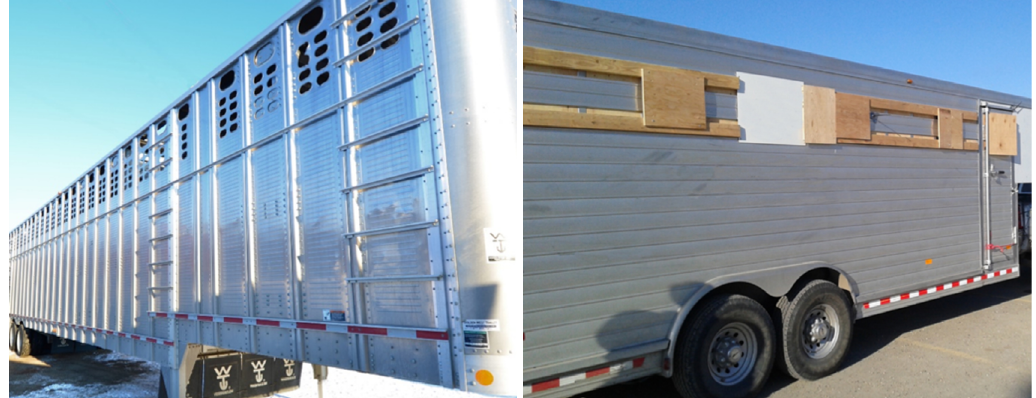
Figure 1. Livestock trailer used to transport caribou from British Columbia to Ontario (16.15 meter Wilson Trailer model PSAGL-400 on left) and Alaska (7.32 meter gooseneck trailer on right) in April 2017. Trailers were modified to reduce light but maintain ventilation and equiped with video cameras to remotely monitor caribou in real-time during